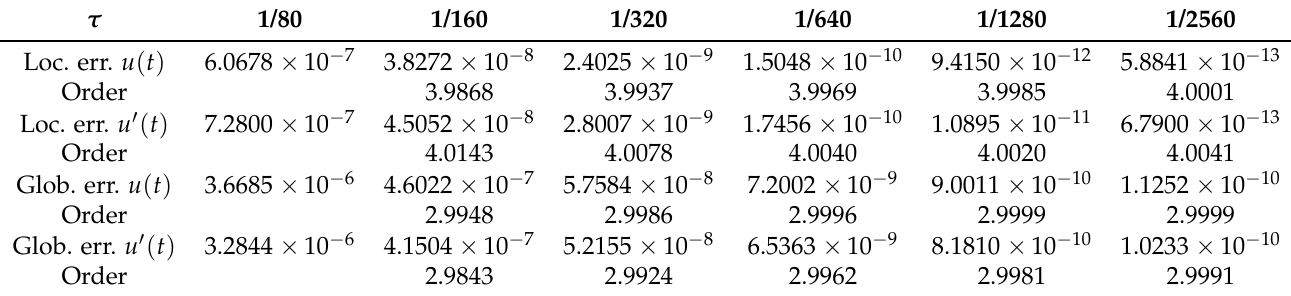
Table 5. Local and global errors and orders for problem (15) with RN3.